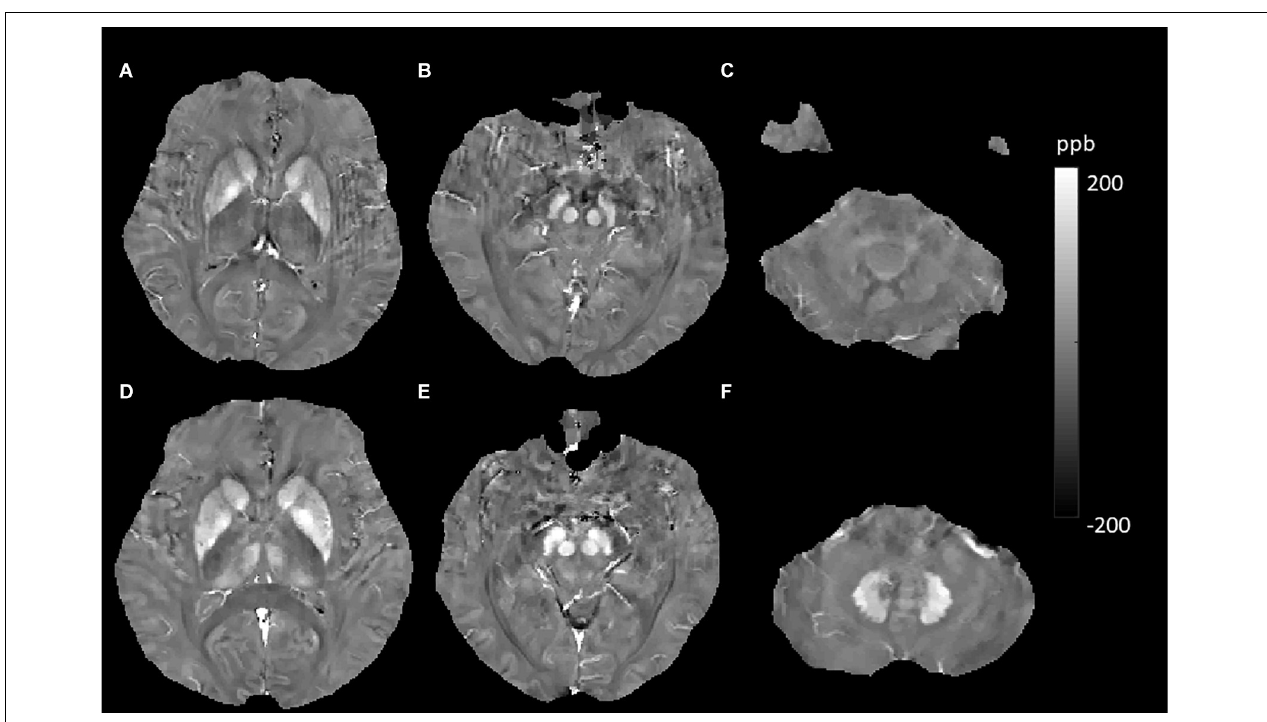
FIGURE 7 | Evolution of susceptibility values with smoking effects in the thalamus. The upper row (A–C) shows susceptibility images of a 56-year-old male non-smoker without hypertension and type 2 diabetes mellitus (T2DM) (first). The bottom row (D–F) shows quantitative susceptibility mapping (QSM) images of a 55-year-old male smoker without hypertension and T2DM (second). The susceptibility value of the thalamus was higher in the second participant than in the first